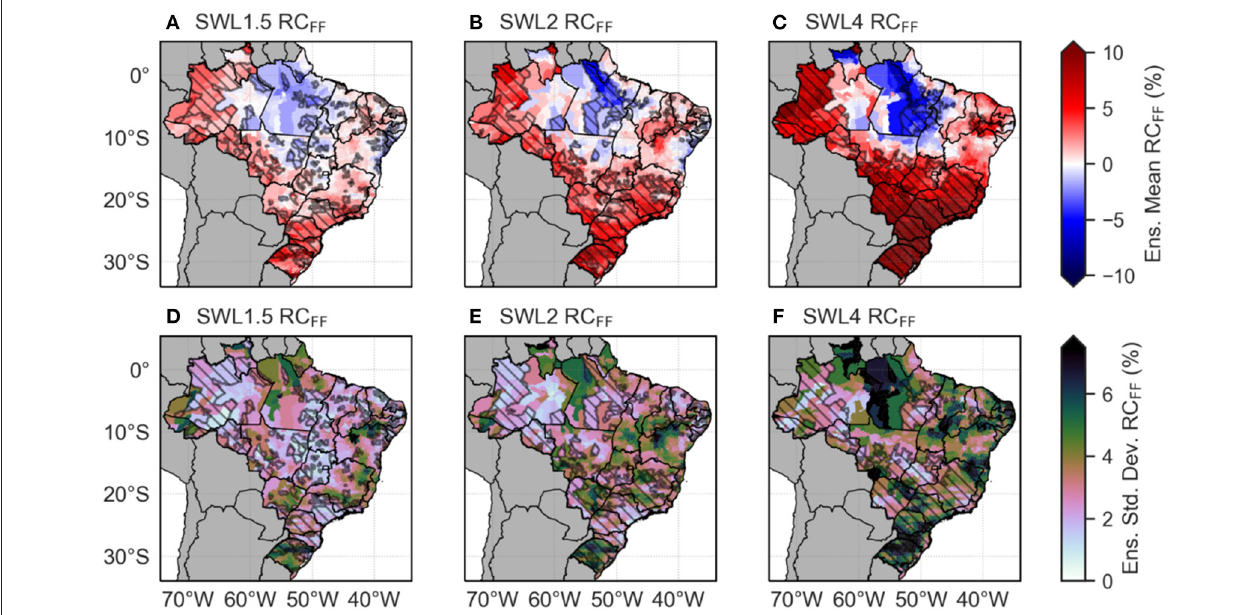
FIGURE 5 | Geographical distribution of the ensemble mean (A–C) and standard deviation (D–F) for relative changes of the potential impact index for flash floods (RC FF ) with respect to the historical period under various scenarios: (A,D) GWL1.5; (B,E) 2.0; and (C,F) 4.0. The hatch pattern represents areas where the ensemble sign agreement presents values above or below + 66 or − 66%,